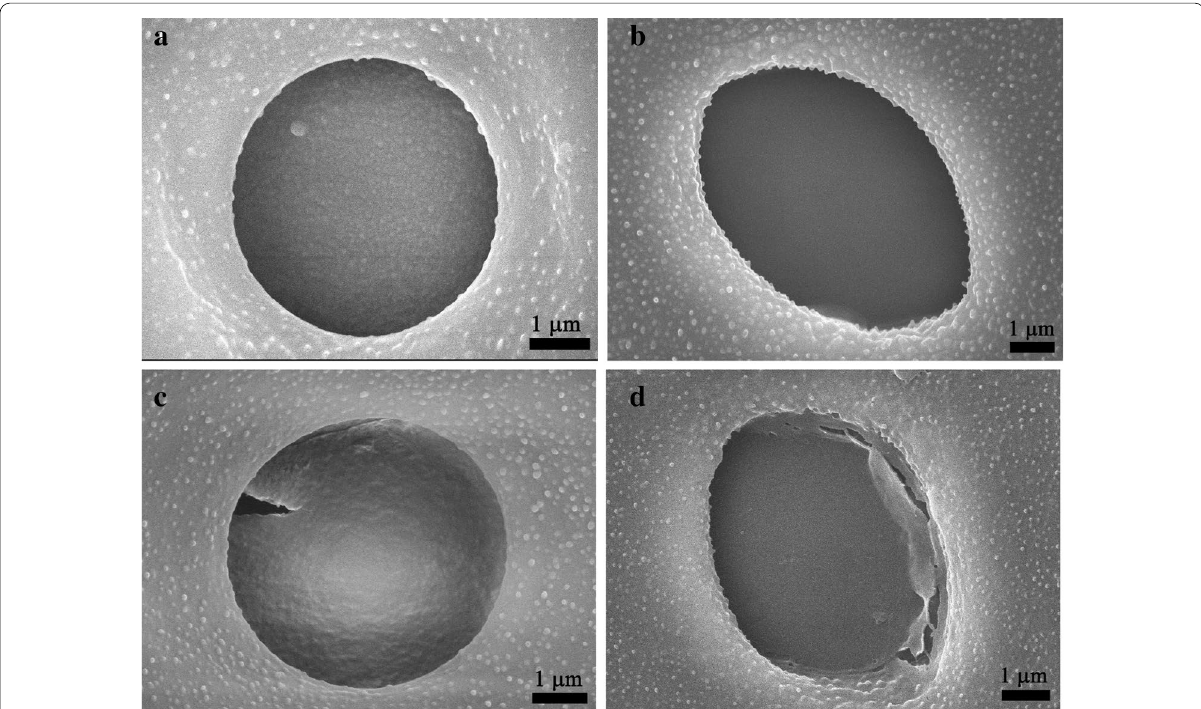
Fig. 6 SEM images of wood pits: a bordered pit of control sample; b cross-field pit of control sample; c bordered pit of MW-pretreated sample; and d cross-field pit of MW-pretreated sample